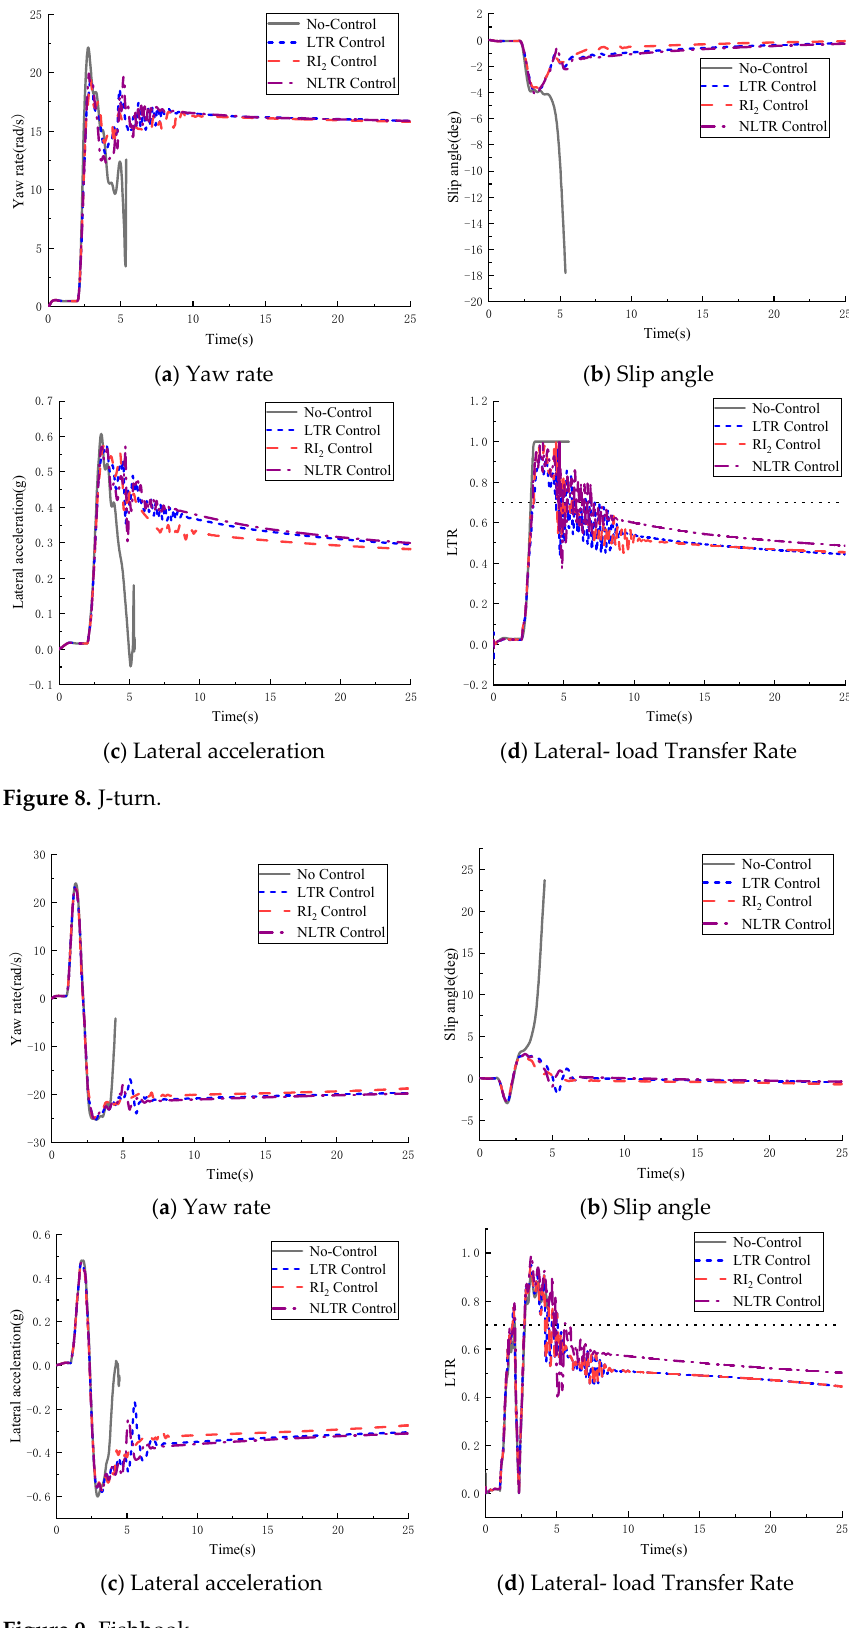
Figure 7. Steering wheel angle.